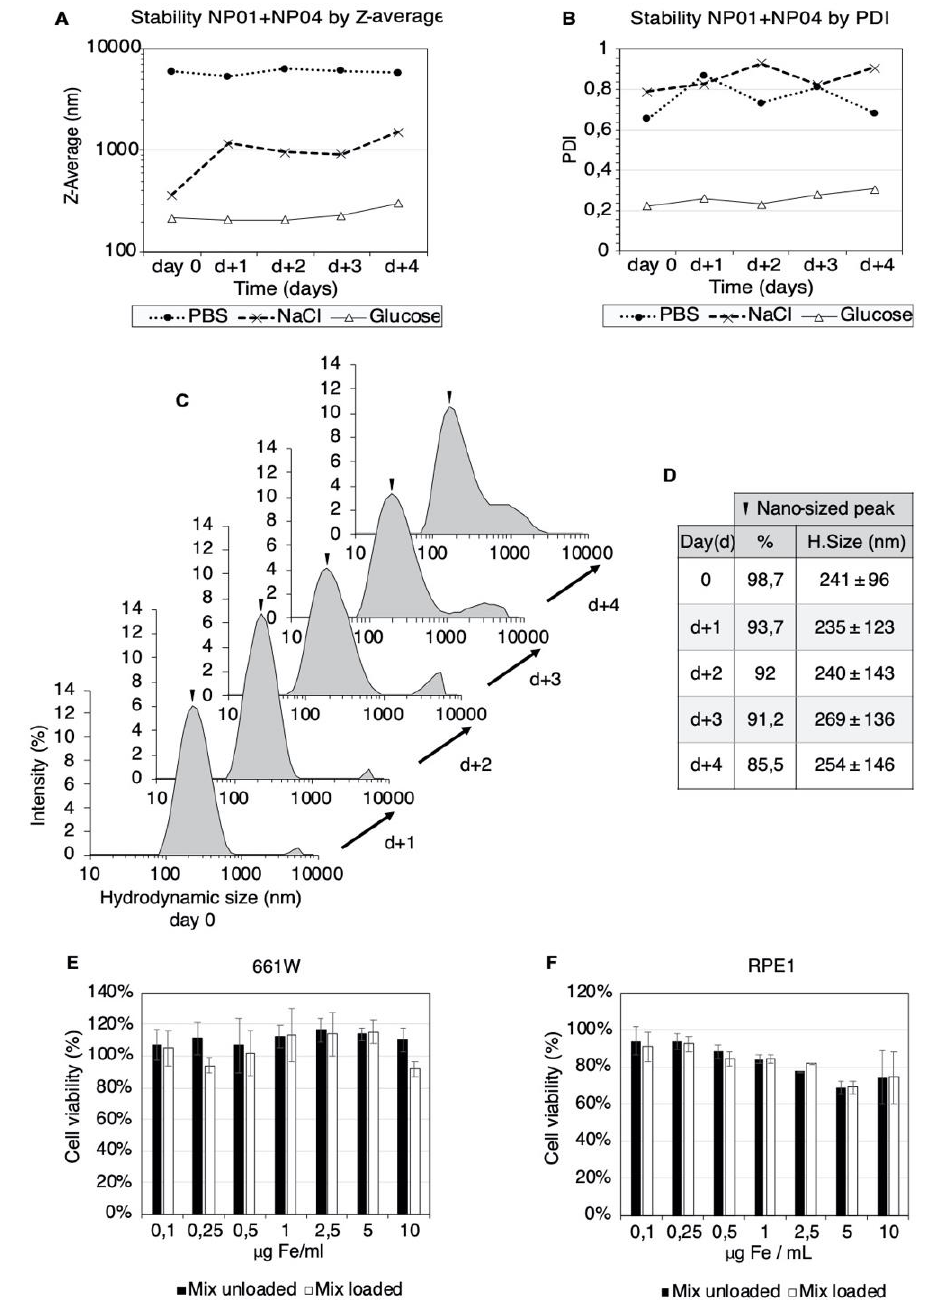
Figure 2. Formulation and biocompatibility of the MNP-based eye drops. Plots of the intensity- weighted mean hydrodynamic size (Z-average) ( A ) and poly dispersity index (PDI) ( B ) of the NP01+NP04 mixtures at different times. Three vehicles were used: 5% glucose (black line), PBS (dotted line) and 0.9% sodium chloride (dashed line). The evolution of the hydrodynamic size of the NP01+NP04 mixture in 5% glucose over four days ( C ). The hydrodynamic size and contribution of the nanosized particle population ( D ). The viability of 661 W ( E ) and RPE1 ( F ) cell lines after exposure to the NP01+NP04 mixture in 5% glucose and 30 min of magnetic targeting. The measurements were carried out after 24 h of incubation. The mean ± SD ( n = 3) from three independent experiments are shown. The results are expressed as a %, using the cells treated with vehicle alone (glucose 5%) as control.